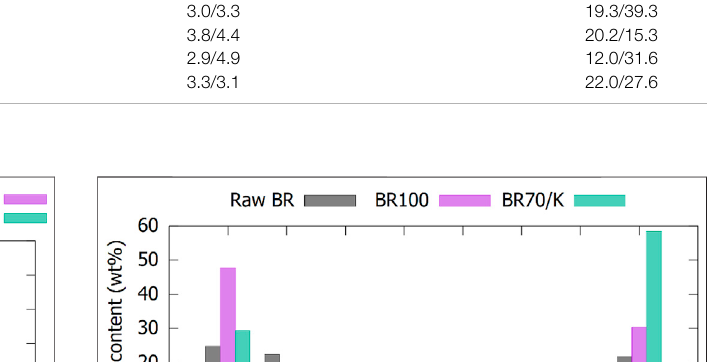
TABLE 2 | Percentiles of the particle size distribution of the BRs before and after calcination. BR d 10 (µm, before/after AlcA